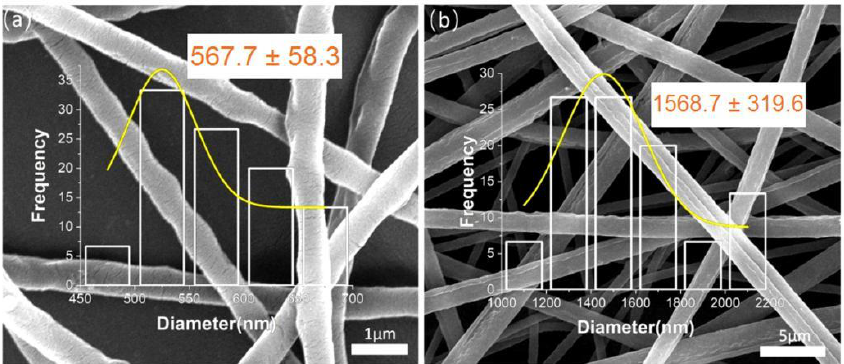
Figure 5. Comparison of uniaxial and coaxial electrospinning fibers: ( a ) uniaxial PEO fiber; ( b ) coaxial PEO–zein fiber.